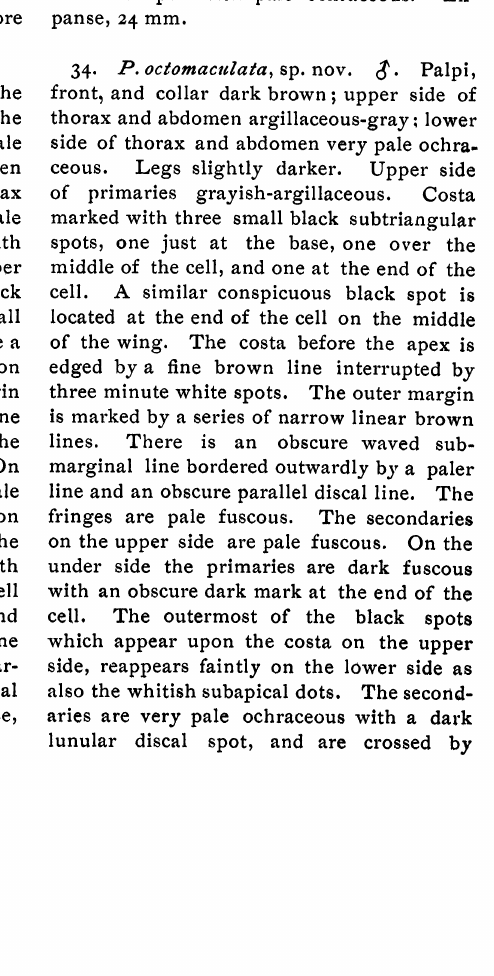
are cinereous with a conspicuous velvety-black triangular spot at the end of the cell. The wings are clouded by dark brown basal, sub- basal, median, and transverse limbal lines, or bands. There is a pale zigzag submarginal line. On the margin at the interspaces there are minute blackish subtriangular spots. The fringes are fuscous, having the cilia at the endsof the nervules slightly paler. The secondaries on the upper side are colored like the primaries and the dark lines and bands of the primaries are produced upon them. There is a dark velvety linear patch of raised scales at the end of the cell. Both wings on the under side are paler than on the upper side, the primaries being darker on the costa and the middle area of the wing.